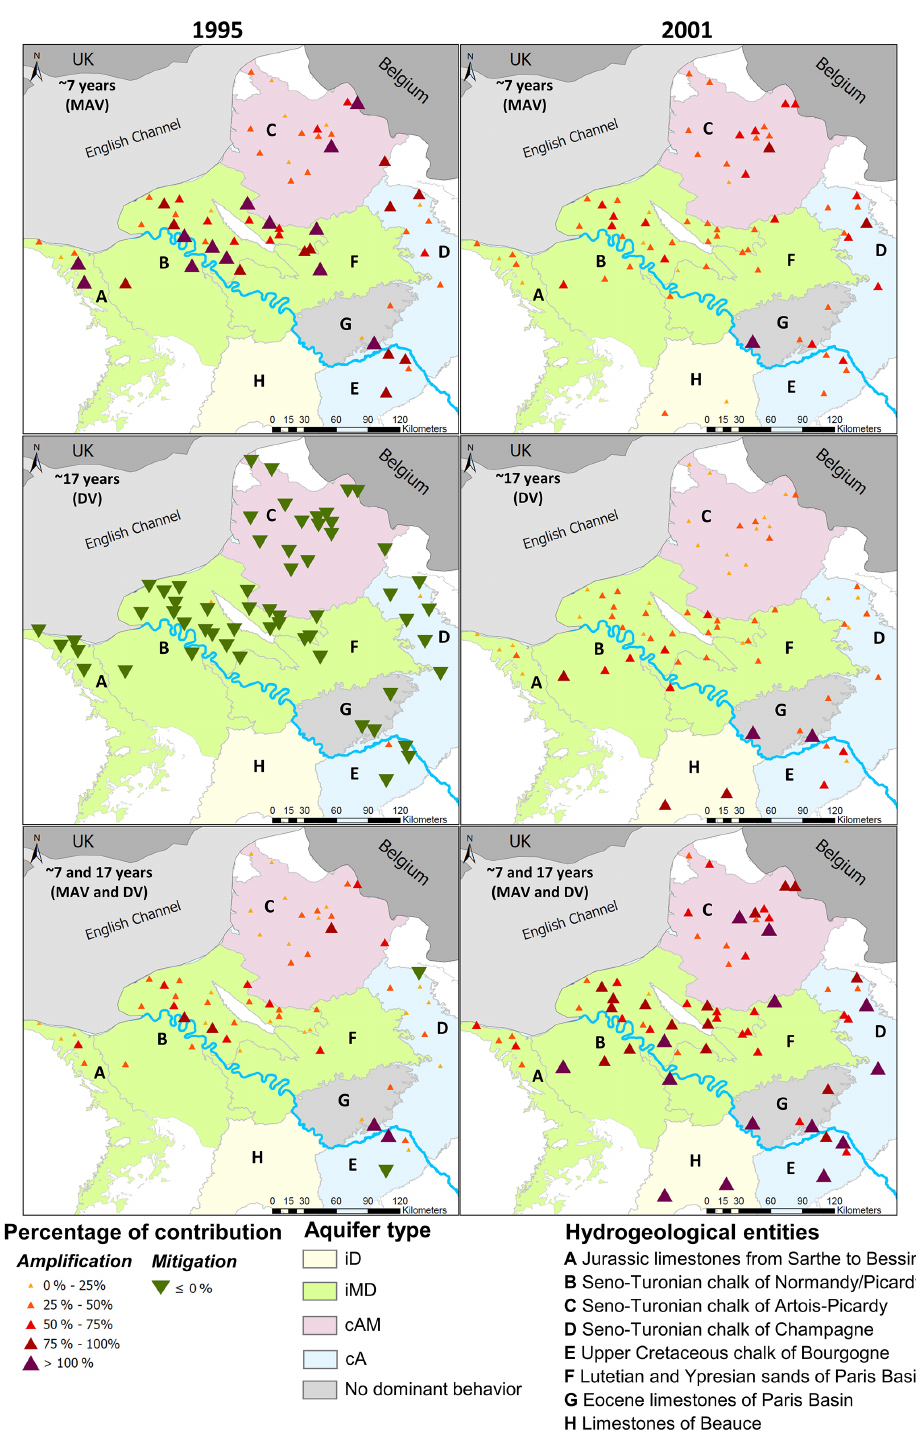
Figure 12. Contribution of ∼ 7-year (MAV), ∼ 17-year (DV), and ∼ 7- and ∼ 17-year components in the amplitude of threshold ex- ceedance (ATE): case of 1995 and 2001 high levels (percentile 0.8). It indicates if the component generates (contribution to ATE ≥ 100%), attenuates (contribution to ATE < 0%), or amplifies (contribution to ATE between 0% and 100%) the high level. In the case of missing borehole(s) on maps, it means that either the 1995 or 2001 high level was not identified in the time series (i.e. no threshold exceedance).